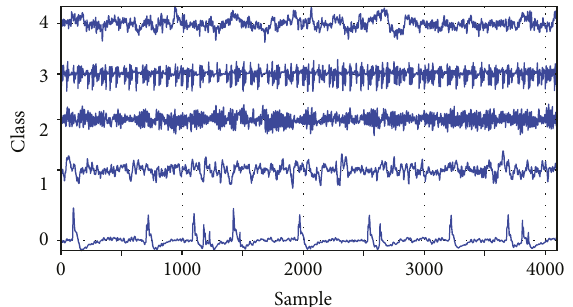
Figure 3: Example of records from each of the 6 classes of the RR dataset.